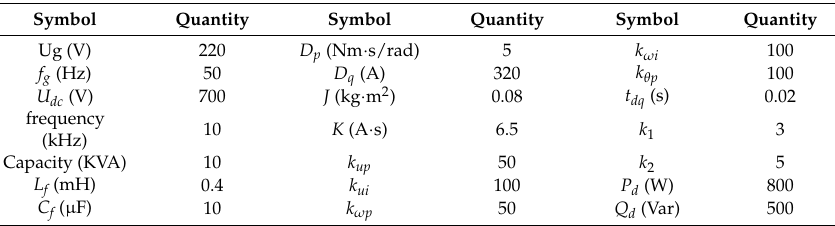
Table 1. Specific simulation parameters.